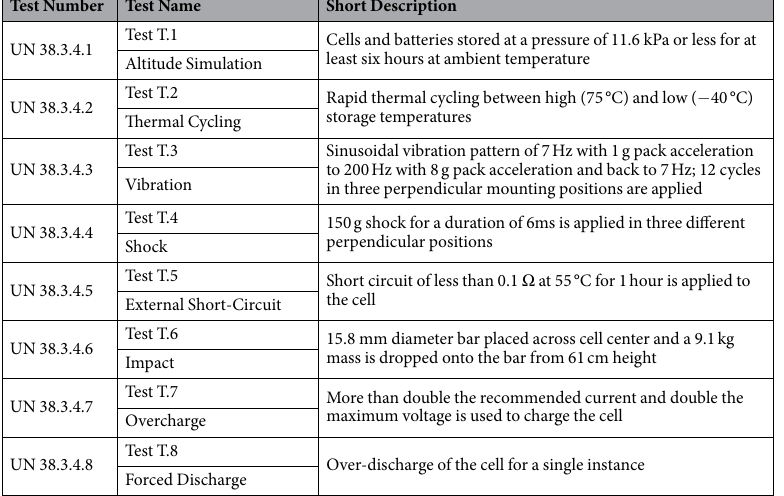
Table 1. UN 38.3 tests for transport certification of lithium-ion